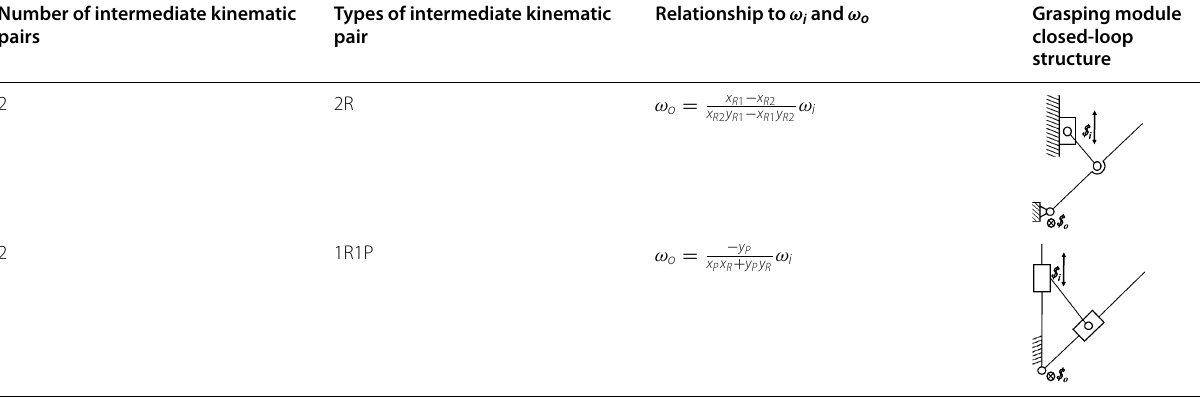
Table 2 Closed-loop structure of grasping module for revolute output joint Number of intermediate kinematic pairs